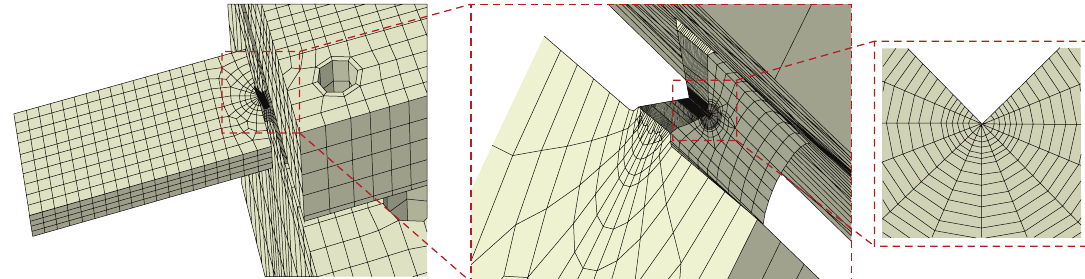
Figure 6: Spider-web configuration mesh at the crack region.